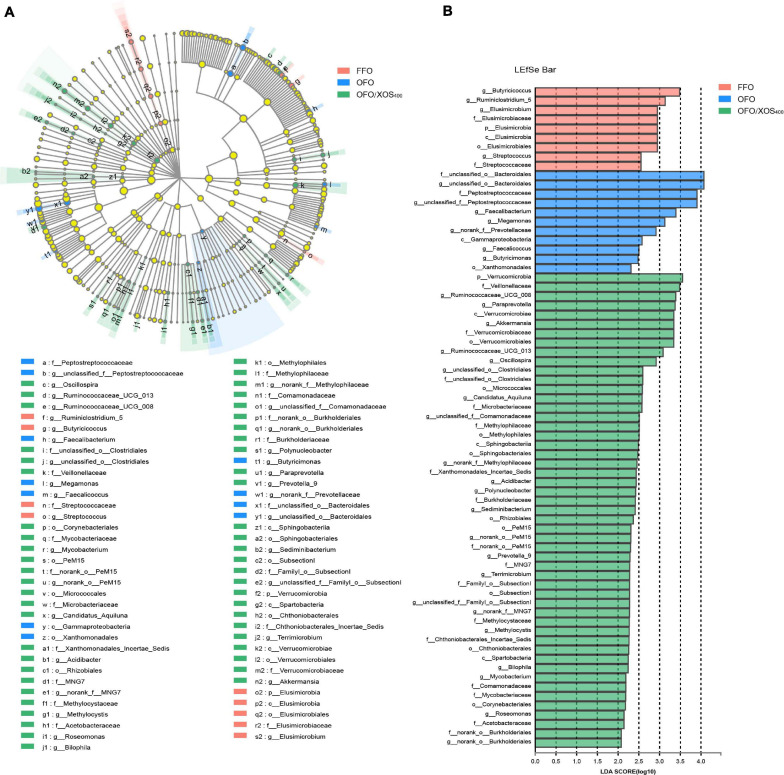
LEfSe identified the most differentially abundant taxa enriched in cecal microbiota among groups FFO (fresh fish oil diet), OFO (oxidized fish oil diet), and OFO/XOS400 (oxidized fish oil diet + 400 mg/kg xylooligosaccharide). (A) Cladogram generated from LEfSe analysis, where red, blue, and green circles represent taxa of greater abundance of hens in the FFO, OFO, and OFO/XOS400 groups, respectively. Yellow circles mean non-significant differences. The diameters of the circles are proportional to the taxon’s abundance. (B) Histogram of the LDA scores computed for features differentially abundant among FFO (red bars), OFO (blue bars), and OFO/XOS400 (green bars) groups. Species with significant difference that have an LDA score greater than 2.0 are presented. The length of the histogram represents the LDA score, which can be interpreted as the effect size of each differentially abundant feature.